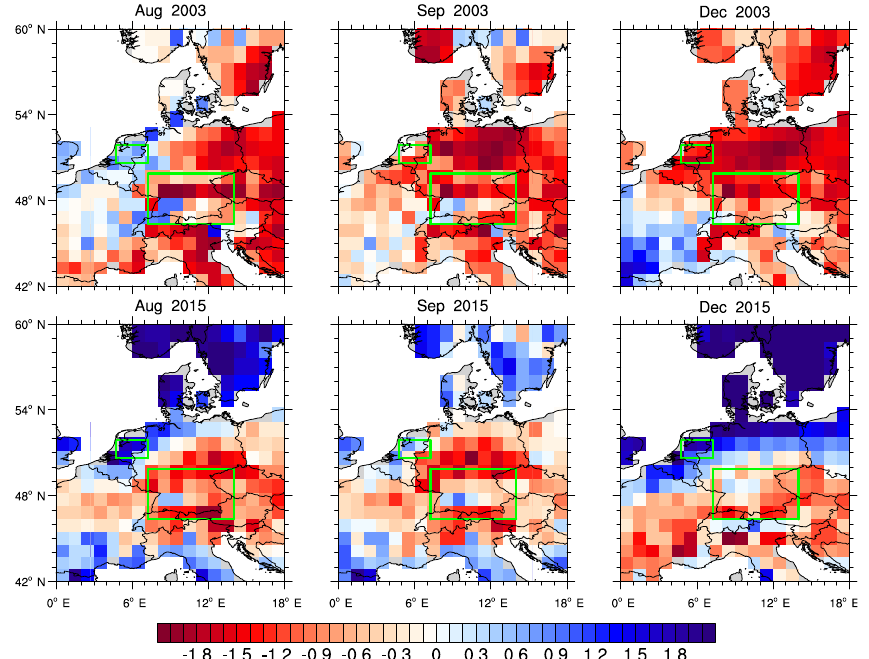
Figure A8. Same as Fig. A1, but after standardisation of the GRACE-CLM groundwater anomalies to de-emphasise the seasonality compo- nent of the